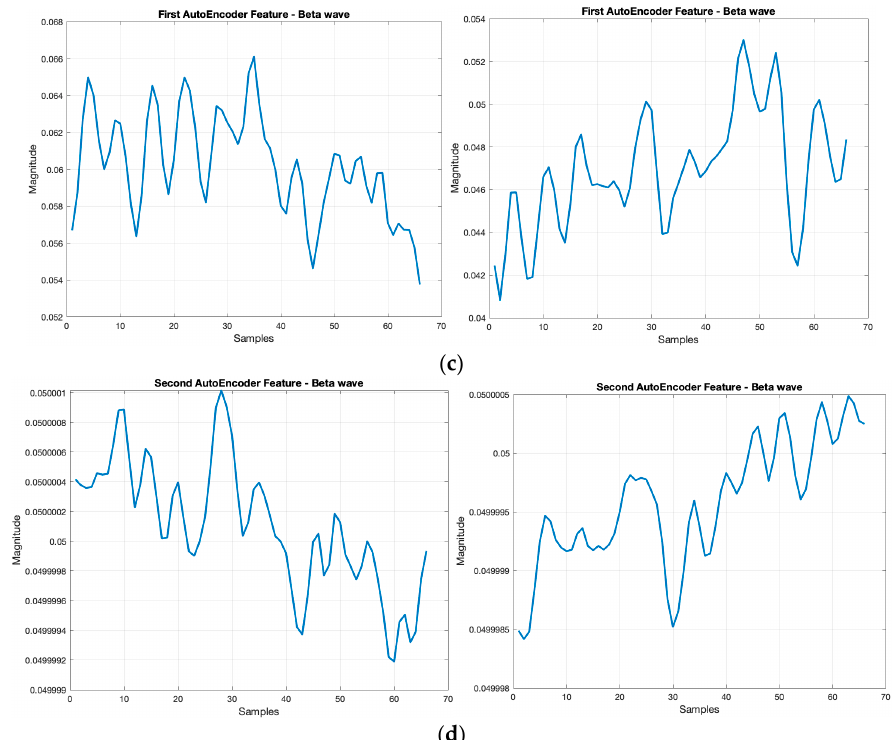
Figure 4. Latent representation of input DCT-based EEG computed by: the first autoencoder block for drowsy ( a ) and wakeful ( c ); the second autoencoder block for drowsy ( b ) and wakeful ( d ).